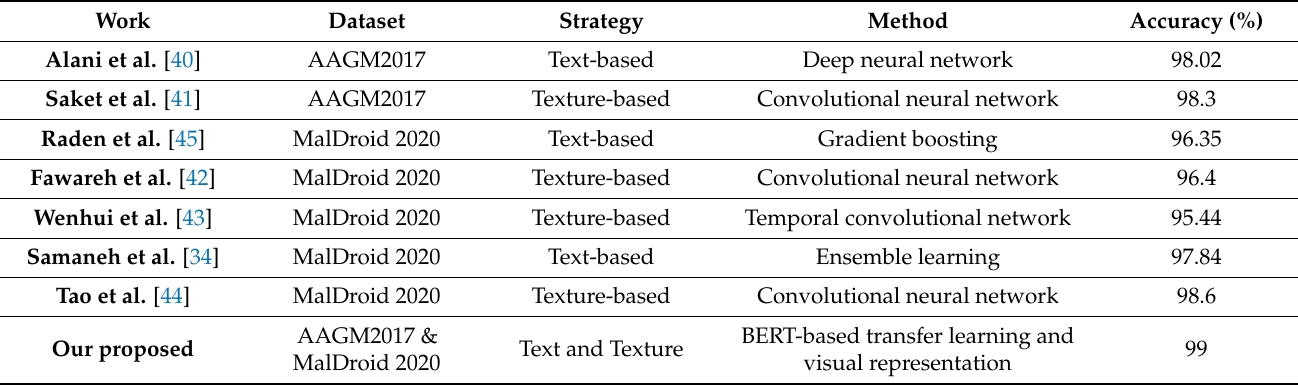
Table 8. Performance comparison with state-of-the-art methods using the same